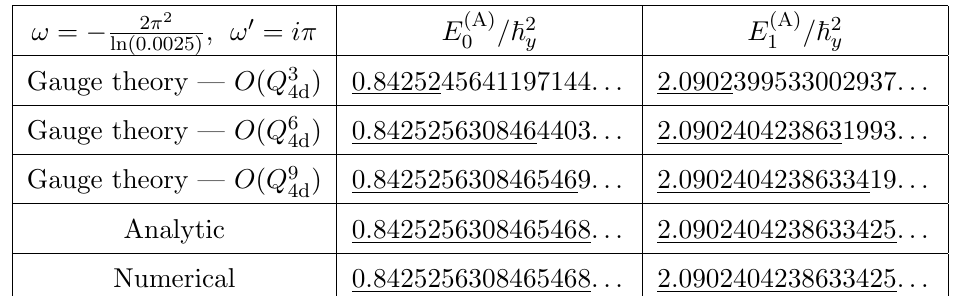
Table 4 . Energies for the 2-eCM A model at g y = 3 table 2.